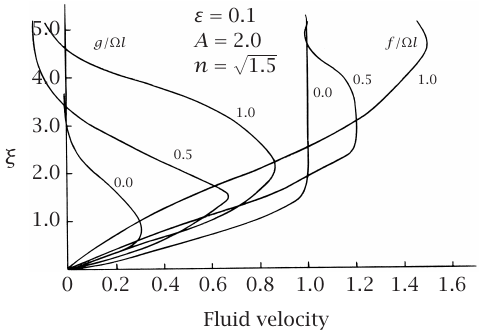
Figure 3.8 . Variations of f/ Ω l and g/ Ω l for different values of the blowing parameter and in presence of A , the magnitude of the fluctuation in blowing velocity.